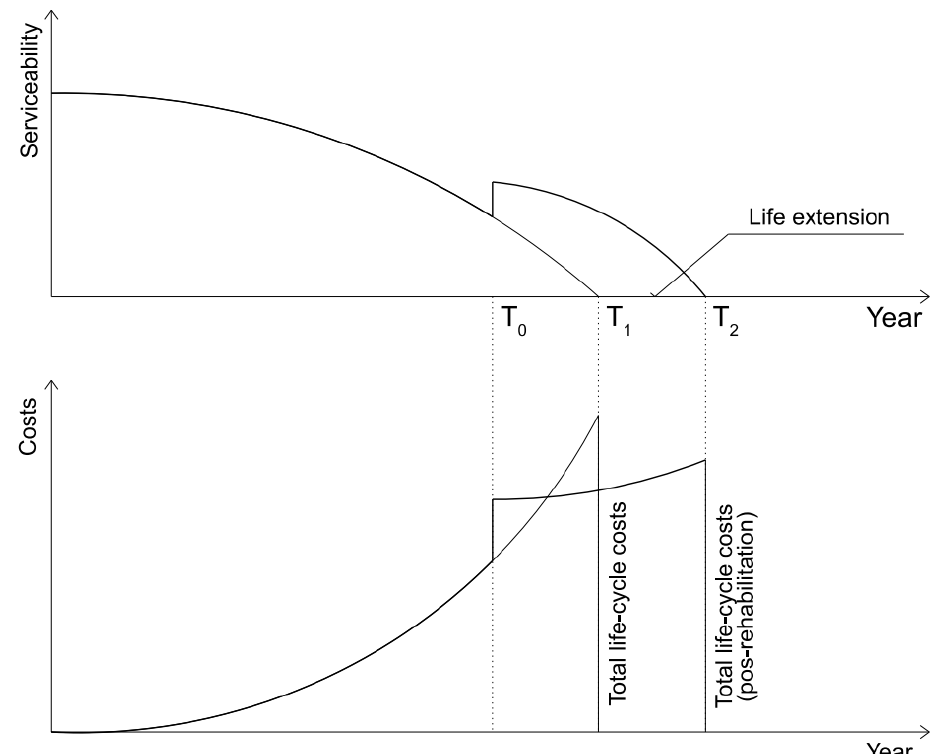
Figure 1. Pavement rehabilitation timing.